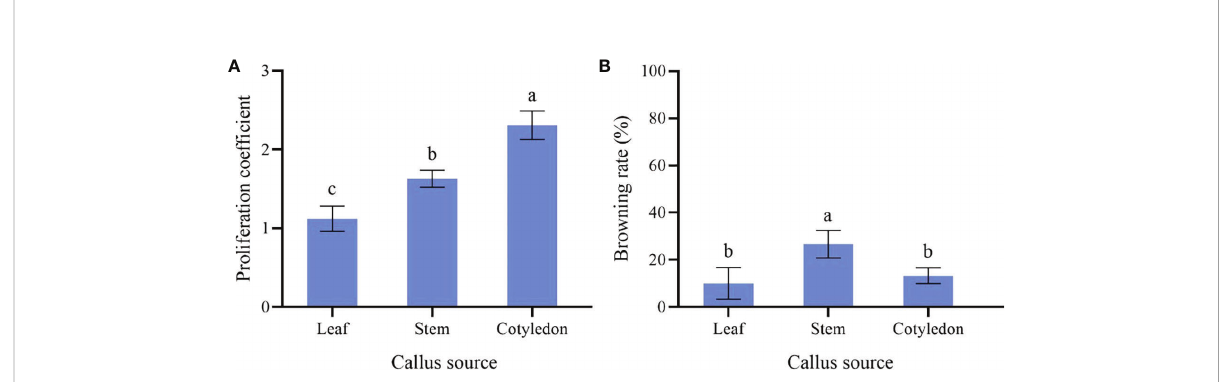
FIGURE 3 Effect of different explants on P. lacti fl ora callus proliferation. (A) proliferation coef fi cient of callus induced by different explants, (B) browning rate of callus induced by different explants, the different letters within a column marked signi fi cant differences (p <